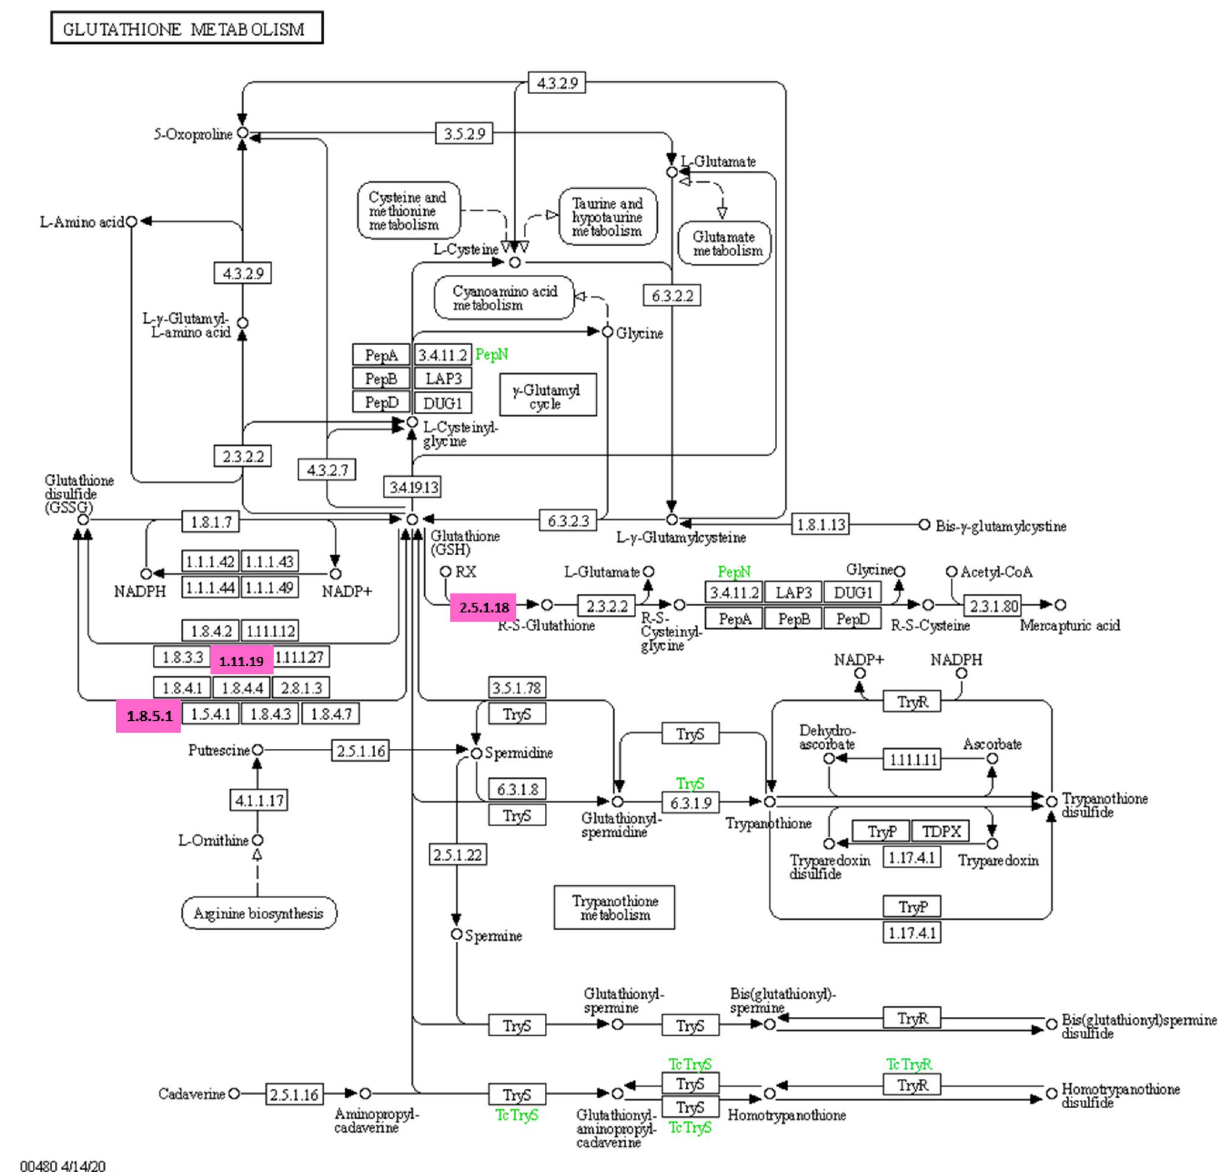
Figure 7. Glutathione metabolism. Pink boxes: upregulated proteins in the HFLac